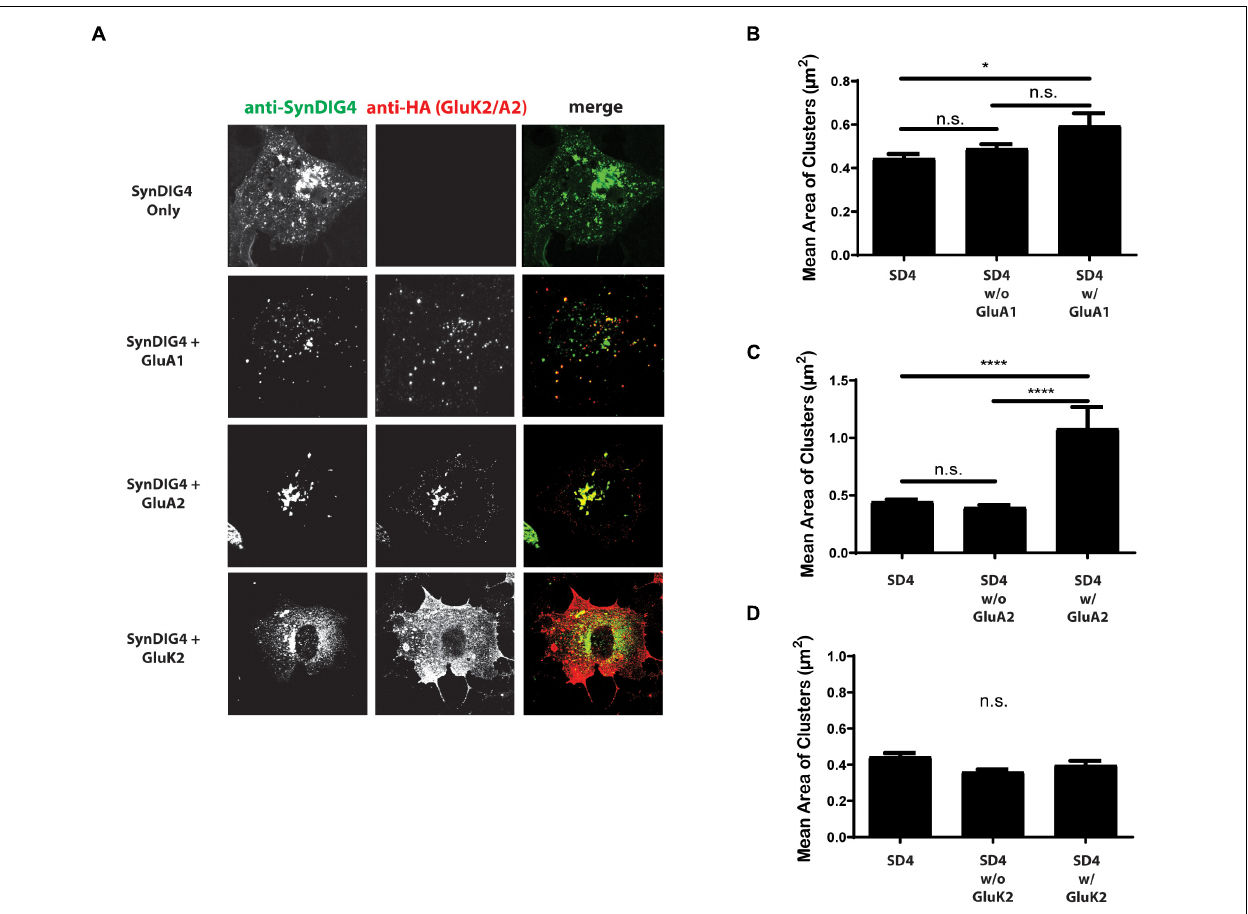
FIGURE 6 | Synapse differentiation-induced gene 4 cluster size increases when colocalized with GluA2. (A) Representative confocal images of COS cells expressing SD4 alone, or SD4 co-expressed with either GluA1, GluA2 or GluK2. Scale bar = 20 µ m. (B–D) Graph depicts the mean area of SD4 clusters stratified for either co-localized or non-colocalized with GluA1 (B) , GluA2 (C) , or GluK2 (D) . (B) SD4 alone ( n = 12), SD4 w/o A1 ( n = 10), SD4 w/ A1 ( n = 10). (C) SD4 alone ( n = 12), SD4 w/o A2 ( n = 10), SD4 w/ A2 ( n = 10). Data are represented as mean ± SEM; n.s. not significant; * p < 0.05; **** p < 0.0001; one-way ANOVA with post-hoc Tukey’s